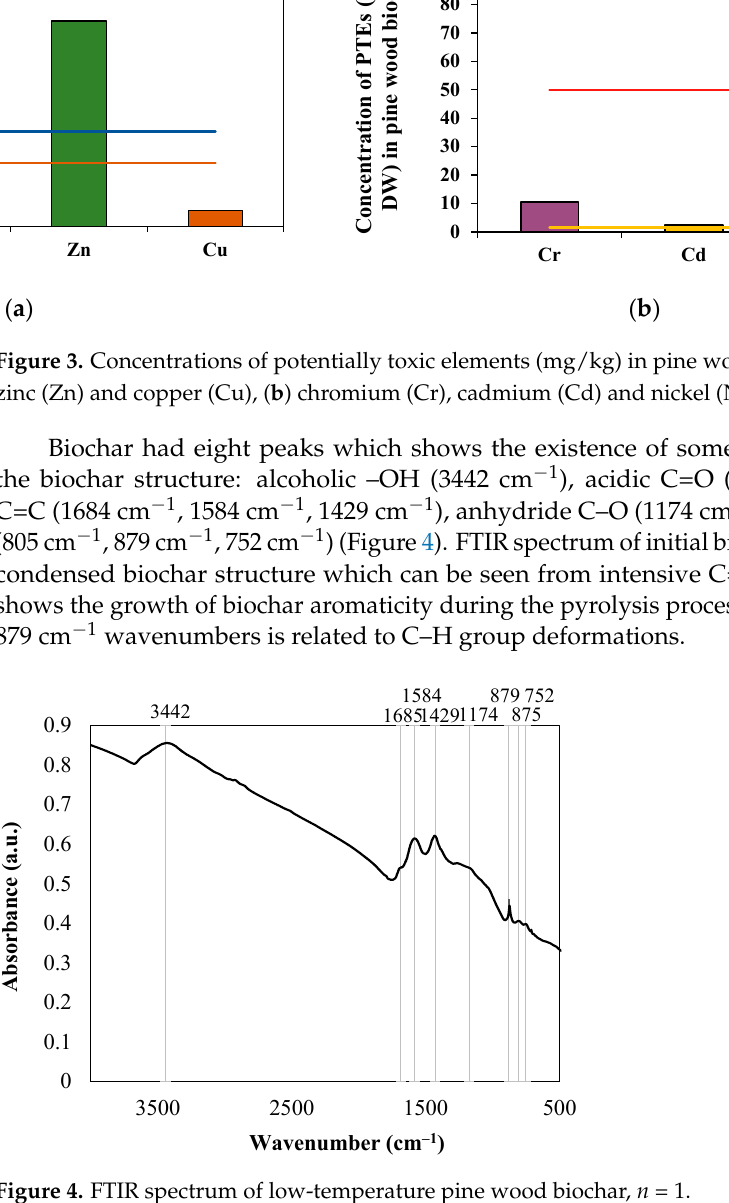
Figure 4. FTIR spectrum of low-temperature pine wood biochar, n = 1.